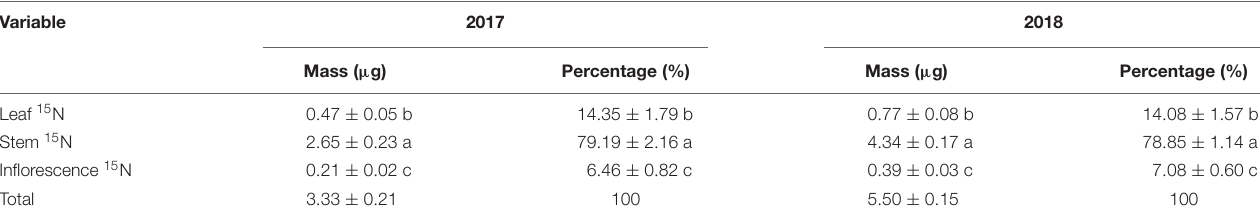
TABLE 3 | Mean translocated 15 N mass allocation to various organs of reproductive ramets in Leymus chinensis over two consecutive years (means ± SE, n = 4).